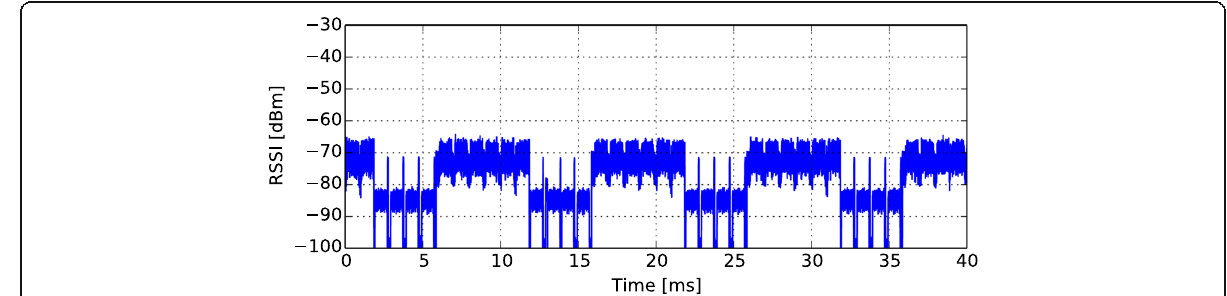
Fig. 12 TDMA WMP-WiFi over LTE-U